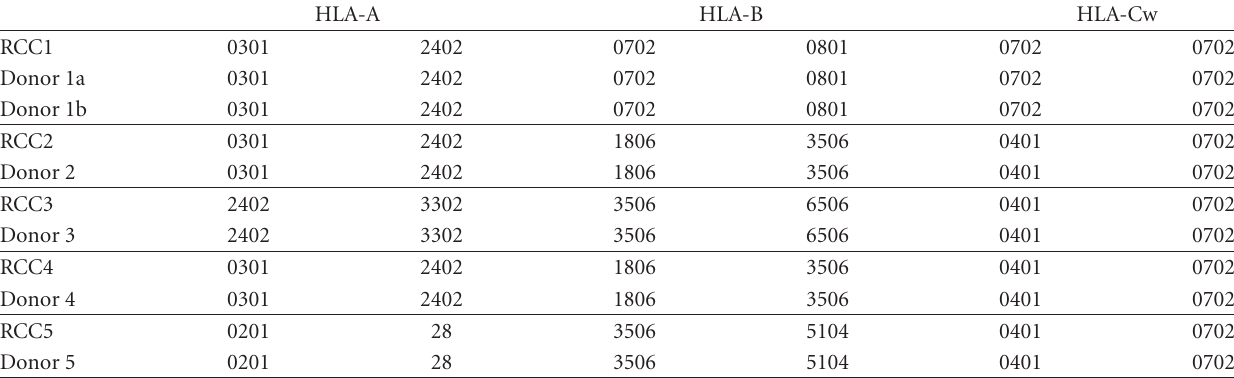
Table 1: HLA-class I genotyping of RCC patients and healthy